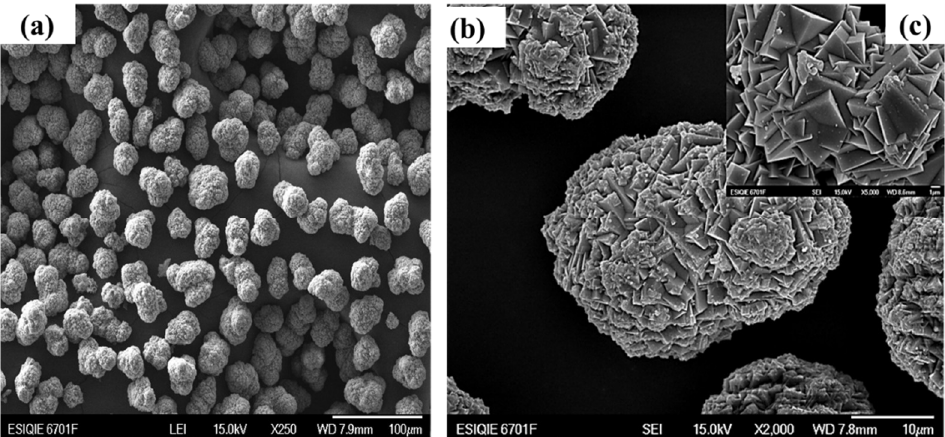
Figure 1. ( a ) Image of the aggregates of synthetic ammonium-sodium jarosite with arsenic. ( b ) Detailed image of an aggregate with spherical tendency, ( c ) Semi-detailed image of rhombohedral microcrystals of ammonium-sodium jarosite with arsenic (Images obtained by SEM-SE). The obtained ammonium-sodium jarosite with arsenic presented a similar morphology and microstructure to those reported for arsenical potassium jarosite and sodium jarosite with arsenic [13,19]. Assessment of the obtained X-ray diffraction spectrum was conducted using Match Version 3. (Crystal Impact, Dr. H. Putz and Dr. K. Brandenburg GbR, Kreuzherrrenstr, Bonn, Germany), which contains the International Center for Diffraction Data-Power Diffraction Files (ICDD-PDF). The intensity of the peaks shown in Figure 2 suggested the presence of crystallographic planes typical of ammonium jarosite, albeit slightly shifted to the left due to the unit cell’s expansion caused by the incorporation of the arsenate ion (AsO 43 − ) [22]. No other compounds were identified, as there were no additional intense